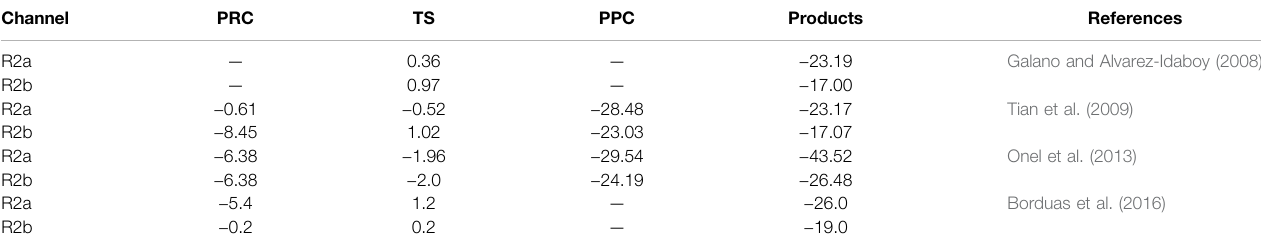
TABLE 3 | Summary of the calculated relative (to reactants) energies (in kcal/mol) of the stationary points in the MEP for the OH + CH 3 NH 2 reaction reported in the literature (see text for more details). Channel PRC